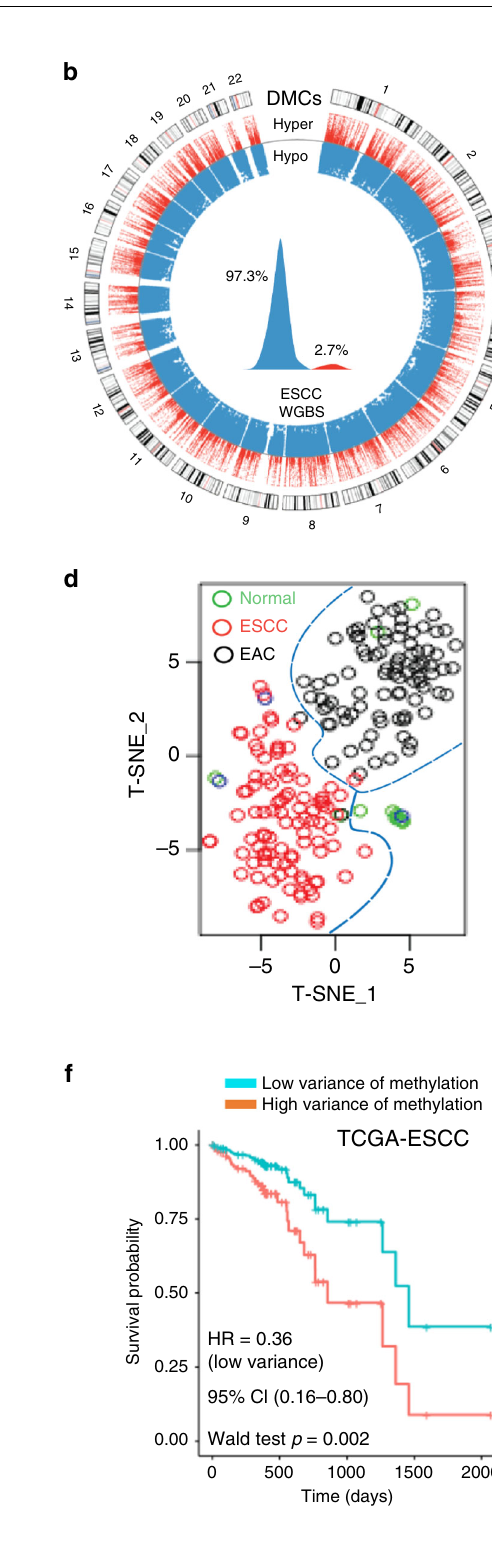
(Supplementary Fig. 7a – c). The group with a lower variance ( n = 49) of methylation levels showed a favorable overall survival time (hazard ratio = 0.36, 95% con fi dence interval (0.16 – 0.80), Wald test p value = 0.002) after normalized to age, gender, and alcohol consumption (Fig. 1f). We examined additional squamous types of cancer including TCGA-head and neck squamous carcinoma cohort ( n = 516) and found that again the high variance of